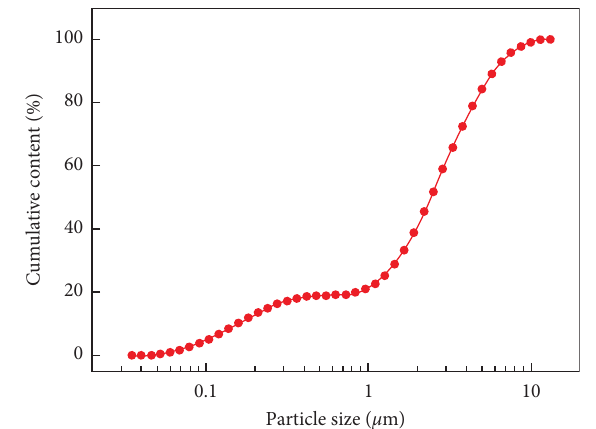
Figure 2: The curve of particle size distribution.